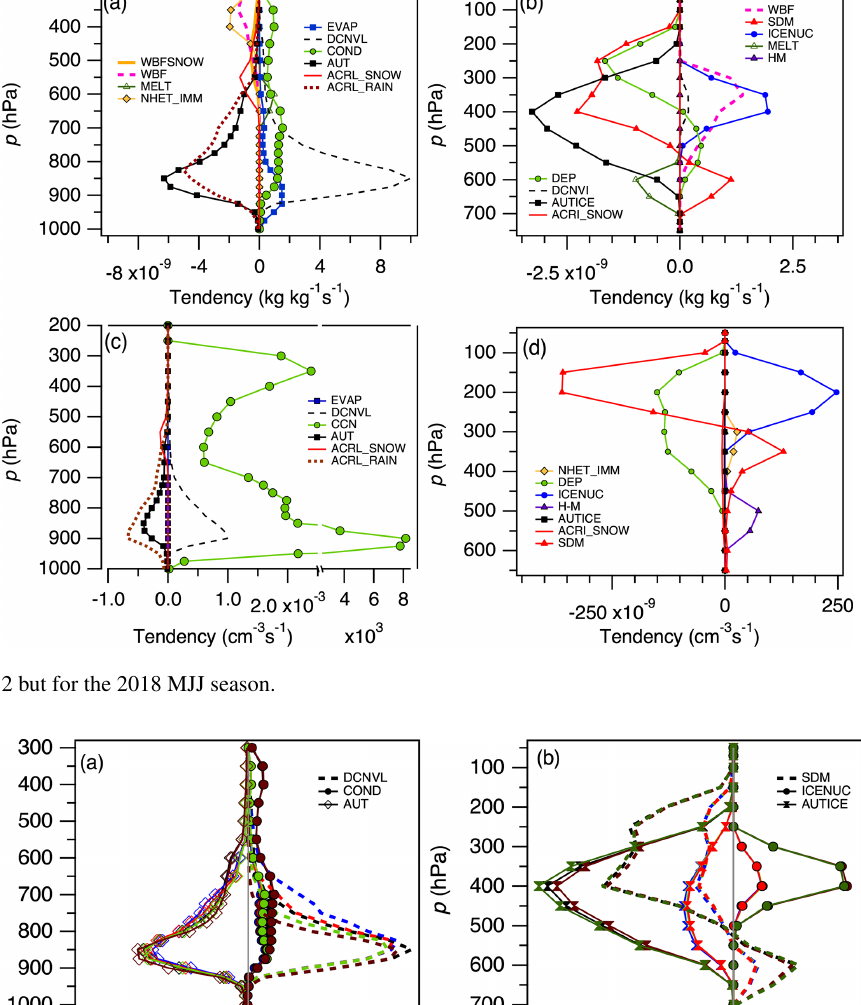
Figure 13. Like Fig. 12 but for the 2018 MJJ season.